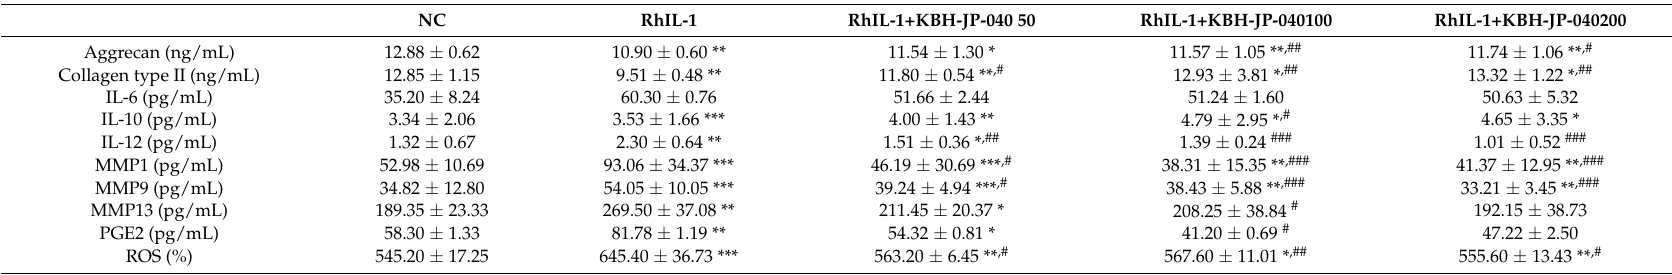
Table 2. Effect of standardized extract (KBH-JP-040) on aggrecan, collagen type-II, inflammatory cytokines, matrix metaloproteins, PGE2 and ROS generation in rat